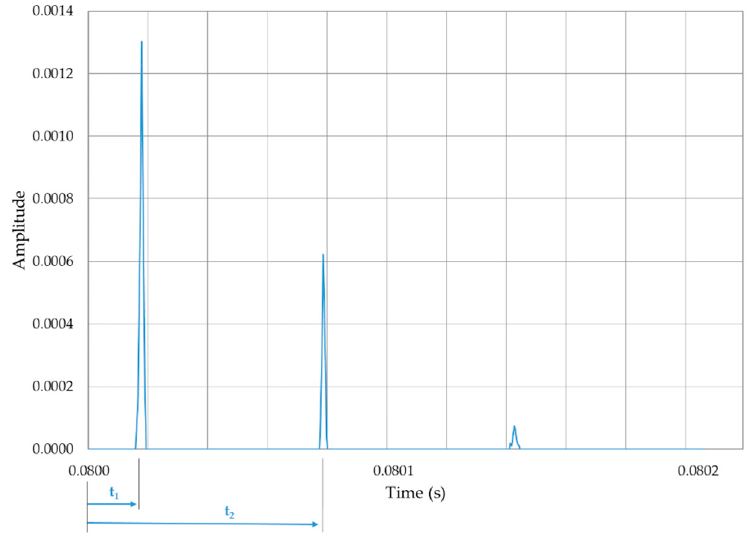
Figure 6. Wavelet modulus maxima (WMM) and arrival times for a current waveform.